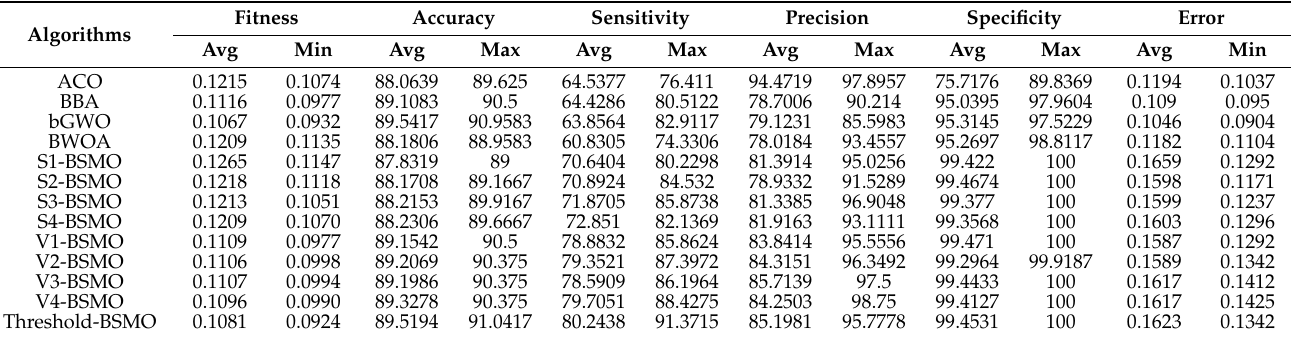
Table 5. Hepatitis disease detection.